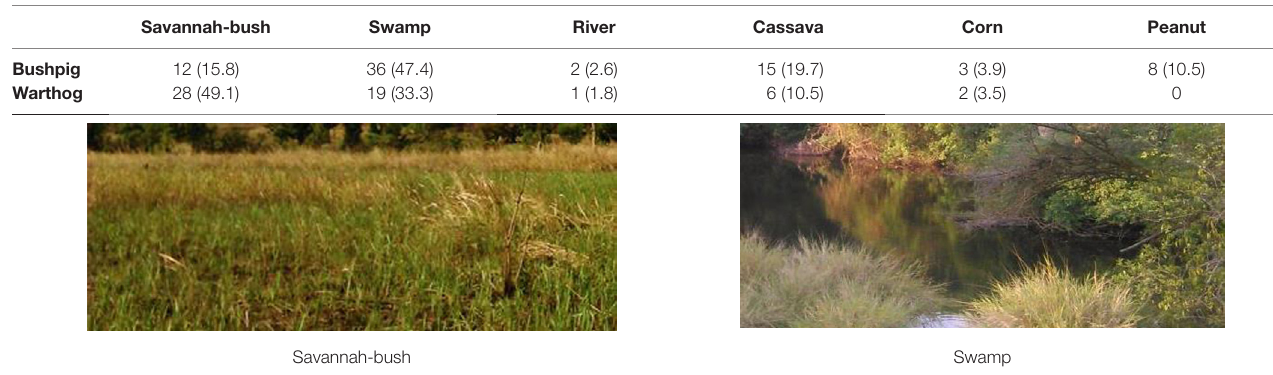
TaBle 2 | number of indirect interactions between domestic and wild pigs per location, described during individual interviews implemented in household-owning pigs at nwoya district, Uganda, in